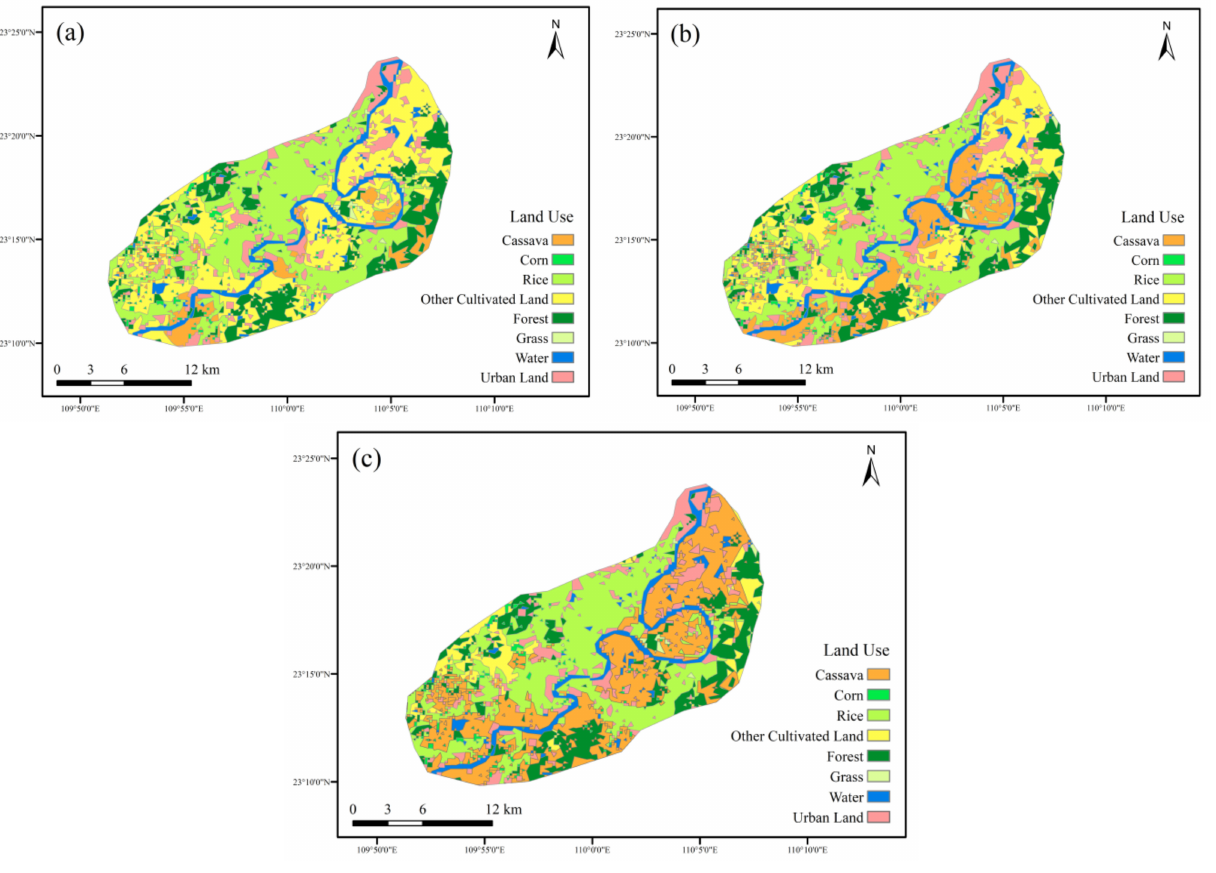
Figure 7. The scenarios of land use ( a )—scenario one; ( b )—scenario two; and ( c )—scenario